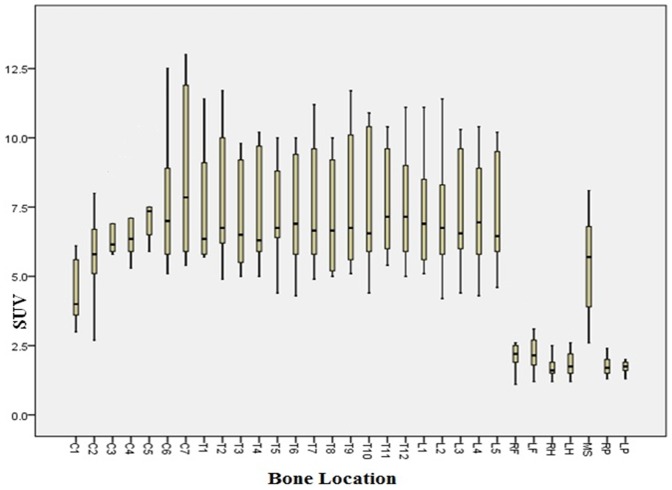
Distribution of SUVmax values of 11 patients and corresponding bone locations (C = cervical, T = thoracic, L = lumbar, RF = right femur, LF = left femur, RH = right humerus, LH = left humerus, MS = mid sternum, RP = right parietal, LP = left parietal).Boxes represent values between 25th and 75th percentiles, horizontal bars inside boxes indicate median, and vertical bars above and below boxes represent 10th and 90th percentiles.